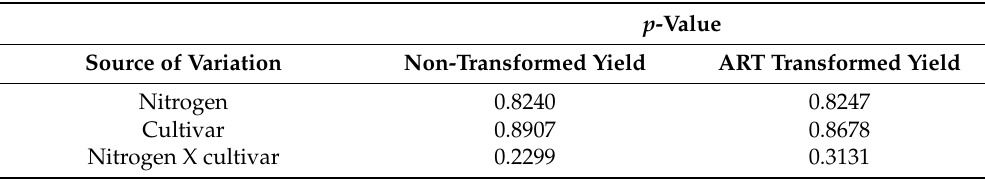
Table 1. p -values for ANOVA of non-transformed and transformed yield data of example